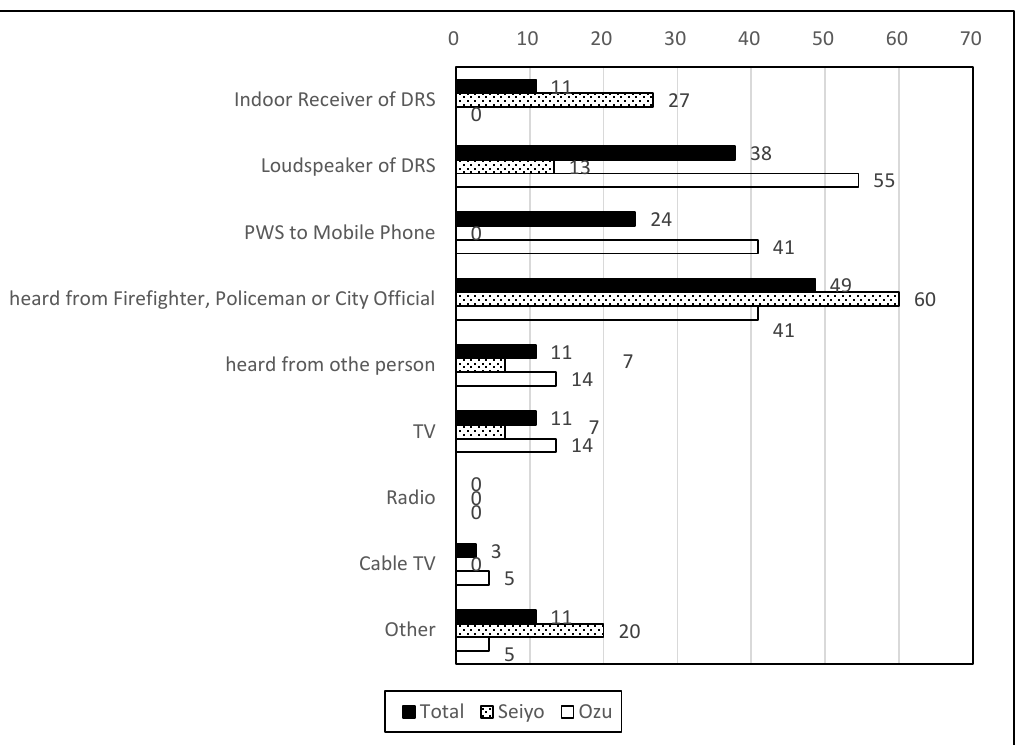
Figure 13. Channels through which evacuation instructions were heard (%), n = 37, (multiple answers).